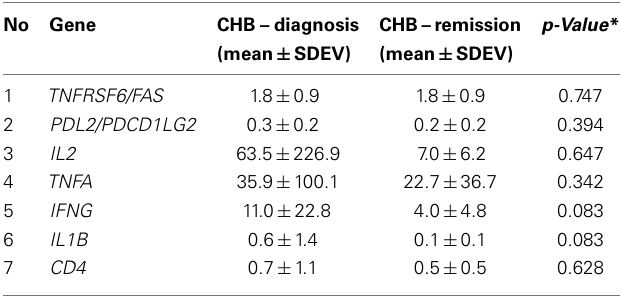
Table 4 | Relative expression of the examined genes with no statistical significance between patients at diagnosis ( n 30) and at remission ( n 23) of the